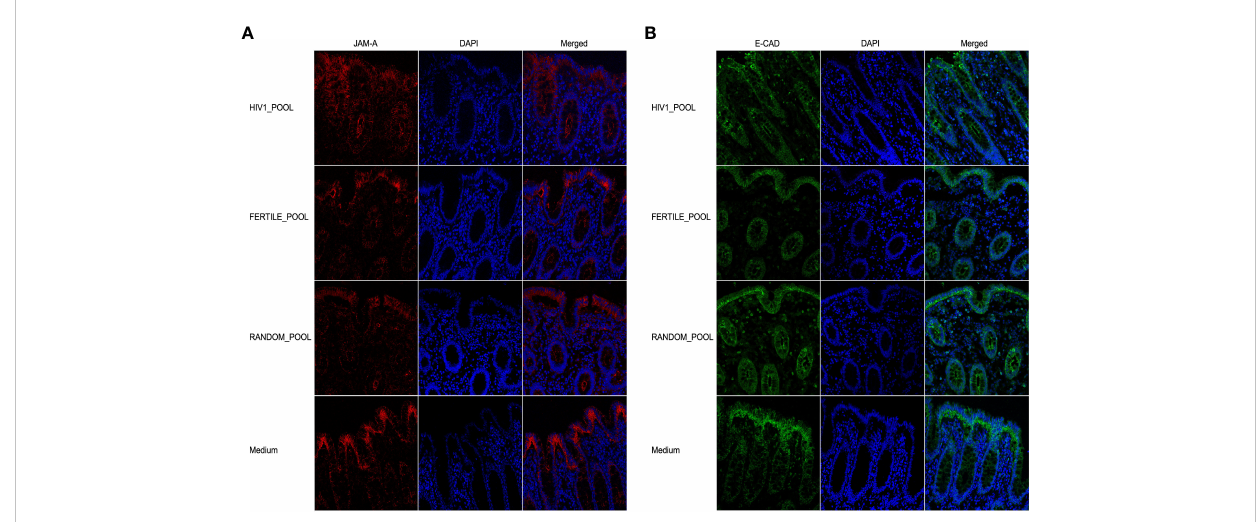
FIGURE 5 HSP does not affect colonic barrier integrity in an ex vivo culture model. Expression of JAM-A (red, (A) ) and E-CAD (green, (B) ) on tissues incubated with three HSP pools for 90 minutes, from 14 HIV infected patients (HIV1-pool), 12 HIV negative fertile subjects (Fertile-pool) or 21 randomly selected donors (Random-pool). Tight junctions were stained with the JAM-A FITC conjugated mAb, and adherent junctions with the E-CAD mAb followed by Alexa Fluor 546-conjugated goat anti-mouse IgG1 antibody. DAPI stained the nuclei (blue). 40X objective magni fi cation are shown.